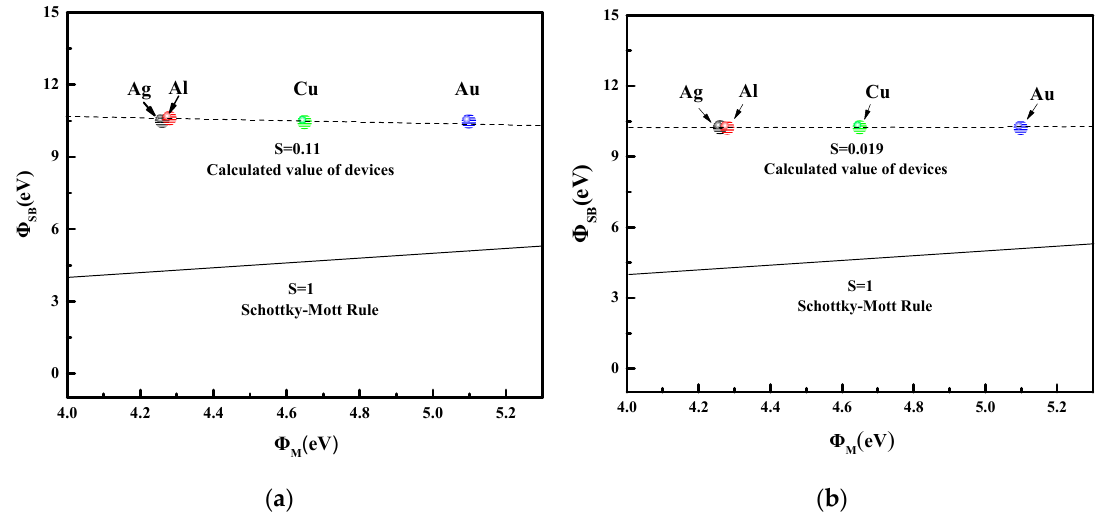
Figure 7. Calculated interface S values of devices comparing to Schottky–Mott rule in ( a ) Group 1 and ( b ) Group 2.